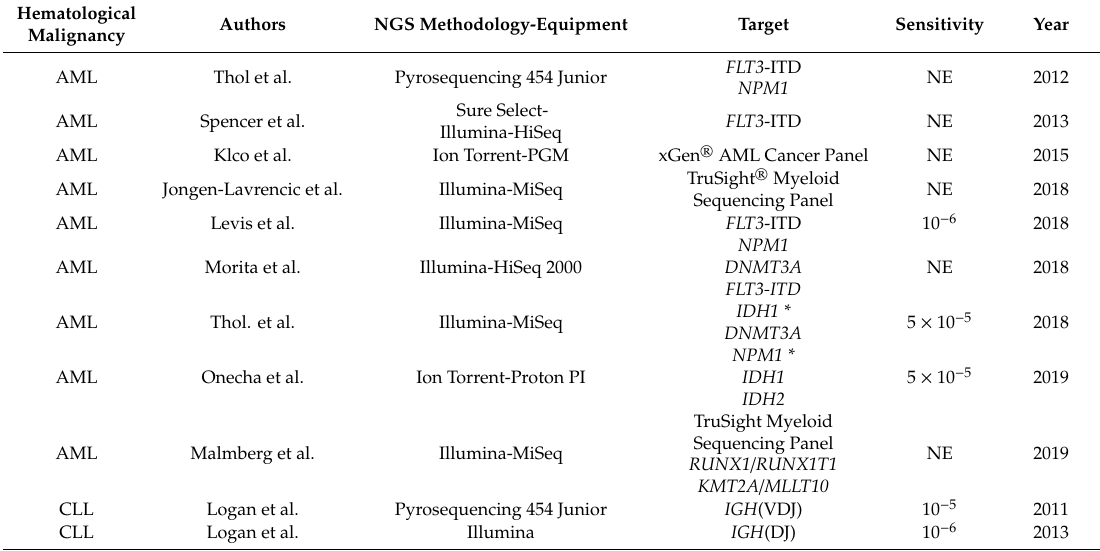
Table A1. High-throughput methods of minimal residual disease determination in hematological